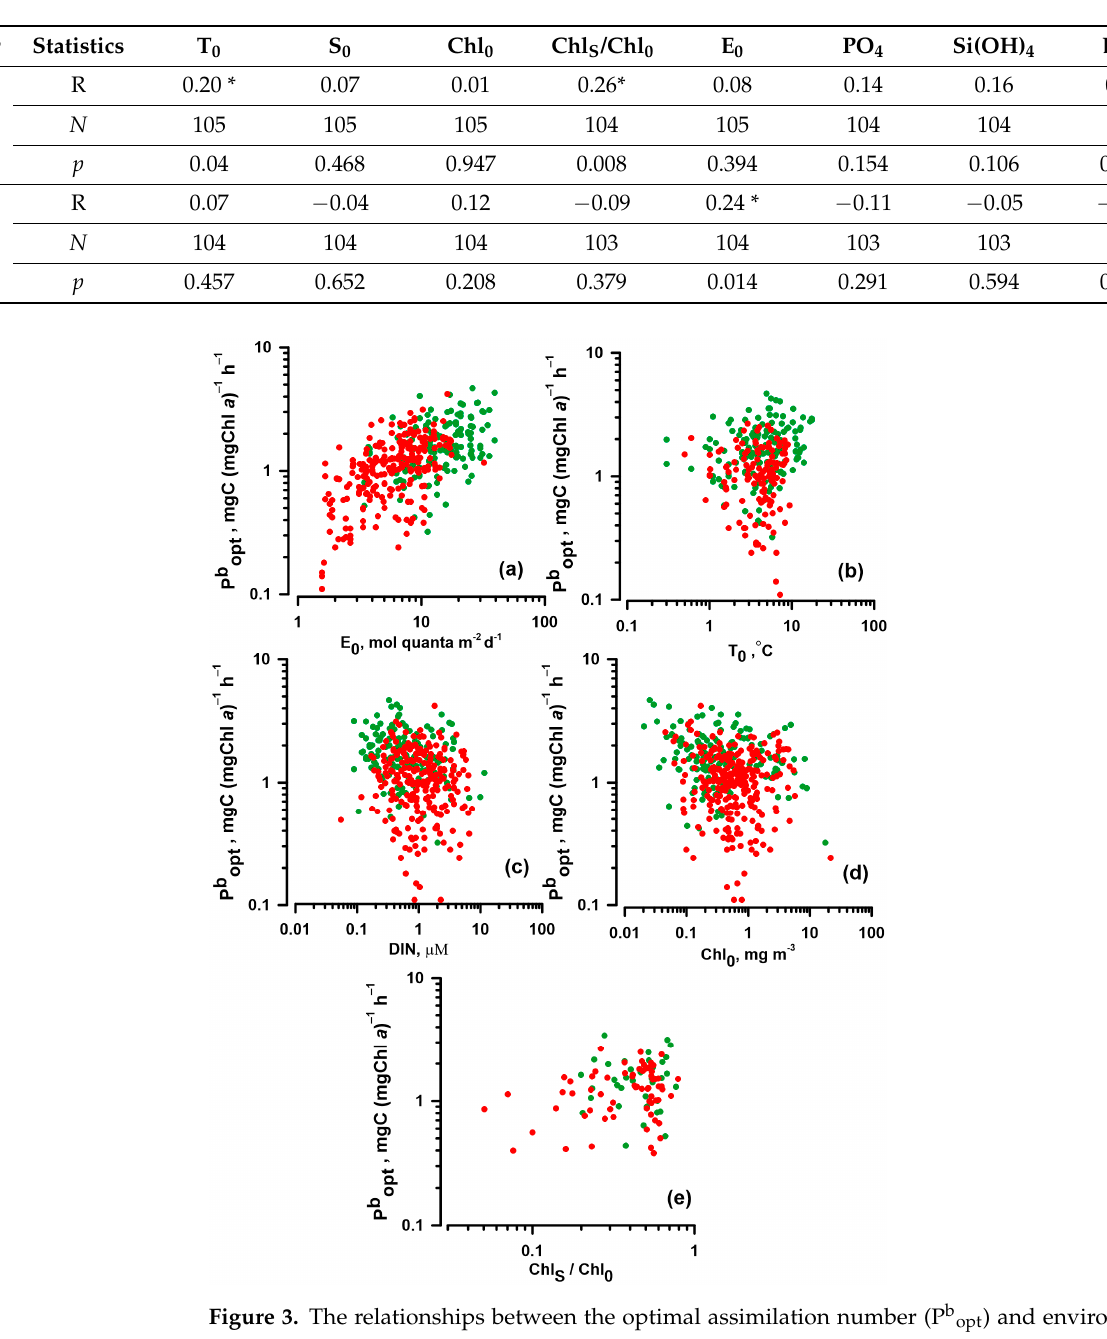
Table 5. The correlation matrix between the log-transformed values of environmental variables. R— coefficient of correlation; p value—statistical significance of R; N —the number of data. T 0 —surface water temperature; S 0 —surface salinity; PO 4 , Si(OH) 4 and DIN—surface concentrations of phos- phates, dissolved silicon, and dissolved inorganic nitrogen, respectively; Chl 0 —surface chlorophyll a concentration; E 0 —subsurface PAR. The asterisks indicate significant correlations ( p < 0.05).